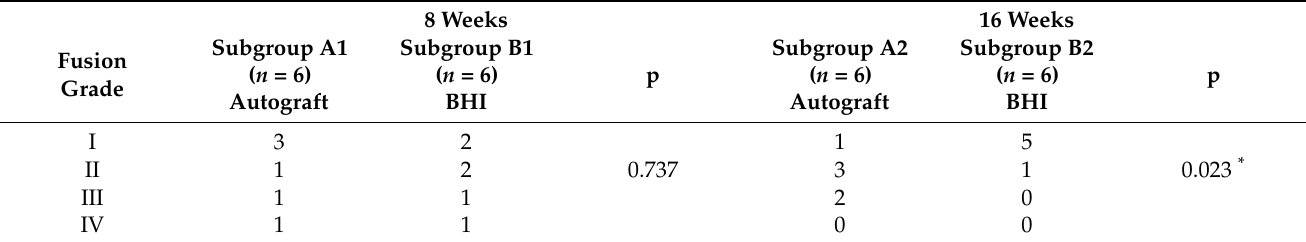
Table 1. Samples of pig spines fused by autograft and bioresorbable hybrid implant (BHI) and their corresponding fusion grades. 8 Weeks 16 Weeks Fusion